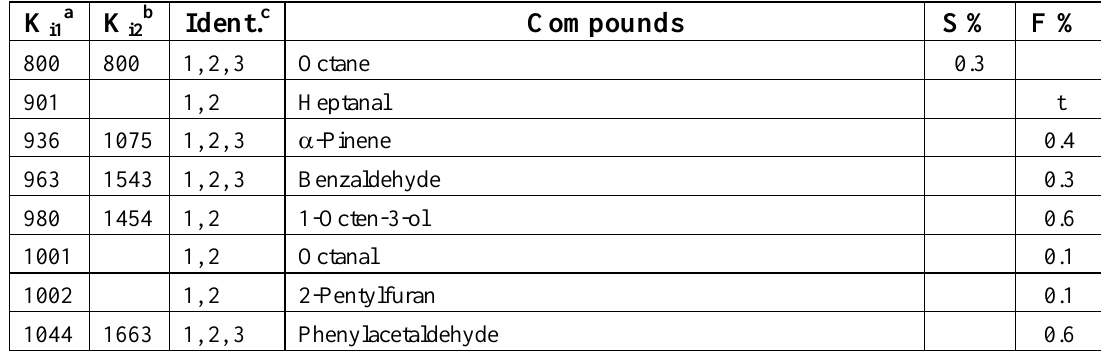
Table 1. Percent composition of the essential oils of stems (S) and fruits (F) of Caralluma europaea (Guss)